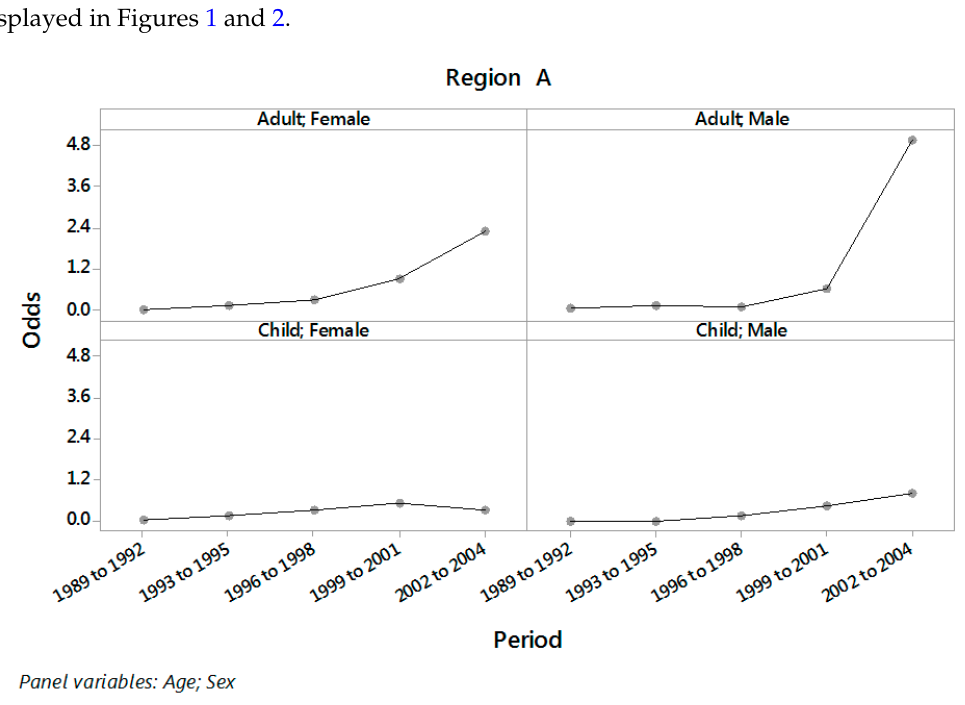
Figure 1. Odds of PH in periods from 1989 to 1992, 1993 to 1995, 1996 to 1998, 1999 to 2001 and 2002 to 2004 for each combination of age and sex in Region A.